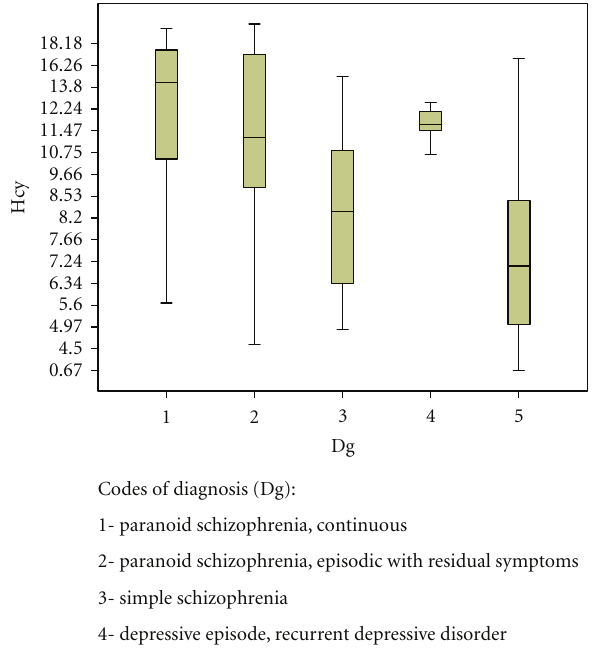
Figure 1: The mean level of Hcy ( μ mol/L) in patients with a ff ective disorders and schizophrenia spectrum